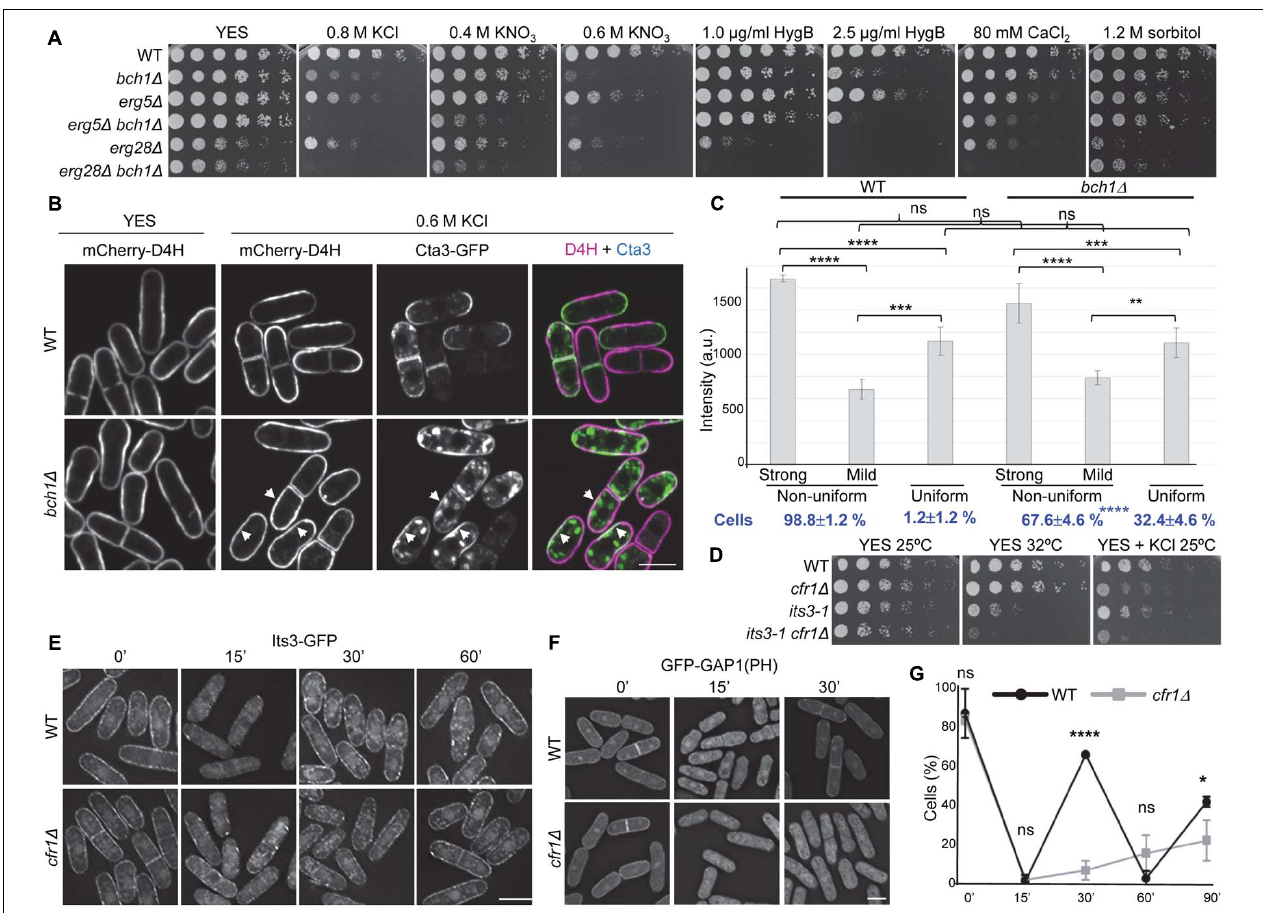
FIGURE 7 | Relationship between exomer and plasma membrane lipids. (A) Cells from the indicated strains were spotted on YES (rich medium) and YES supplemented with the indicated compounds. (B) Wild-type (WT) and bch1 (cid:49) cells bearing the sterol-binding probe mCherry-D4H and Cta3-GFP incubated in YES and YES with 0.6 M KCl for 1 h were photographed under a confocal DragonFly microscope. Single-channel and merged images are SUM projections. Arrowheads denote membrane regions with strong GFP and mCherry signals. (C) Intensity of mCherry-D4H fluorescence (a.u., arbitrary units) in WT and bch1 (cid:49) cell regions with a uniform or non-uniform fluorescence distribution. In the cells with a non-uniform distribution, the intensity in the regions with strong and weak fluorescence was scored. The values from each of four independent experiments were relativized to the WT value in regions with strong fluorescence. The percentage of cells with a uniform and non-uniform fluorescence distribution is shown at the bottom in bold blue lettering. The numbers correspond to the mean, standard deviation, and statistical significance of the differences. The statistical differences were determined using Tukey’s (fluorescence intensity) and Sidak’s (percentage of cells) multiple comparisons tests. ns, non-significant; ** p < 0.01; *** p < 0.001; **** p < 0.0001. (D) Cells from the indicated strains were spotted on YES (rich medium) and YES with 0.6 M KCl, and incubated at 25 and 32 ◦ C for 5 and 3 days, respectively. (E) WT and cfr1 (cid:49) cells bearing Its3-GFP incubated with 0.6 M KCl for the indicated times (minutes) were photographed with a Deltavision system. Images are SUM projections. (F) WT and cfr1 (cid:49) cells with the PI(4,5)P2-binding probe GFP-GAP1 incubated with 0.6 M KCl for the indicated times (minutes) were photographed with a Deltavision system. Images are SUM projections. (G) Percentage of WT and cfr1 (cid:49) cells with GFP-GAP1 fluorescence at the cell periphery. Cells were incubated with 0.6 M KCl and photographed at the indicated times (minutes). For each time, the mean of four independent experiments, standard deviation, and statistical significance of the differences, determined using Sidak’s multiple